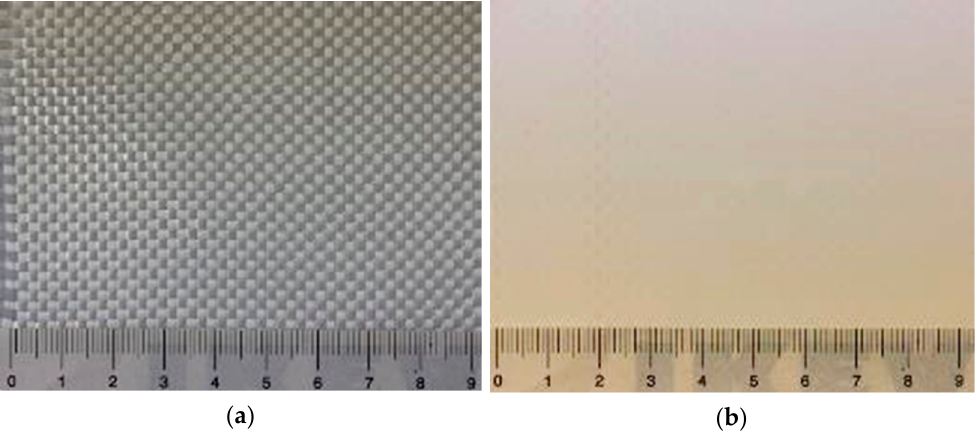
Figure 8. PET-PVC Type III: ( a ) uncoated woven PET fabric; and ( b ) PVC coated woven PET fabric.